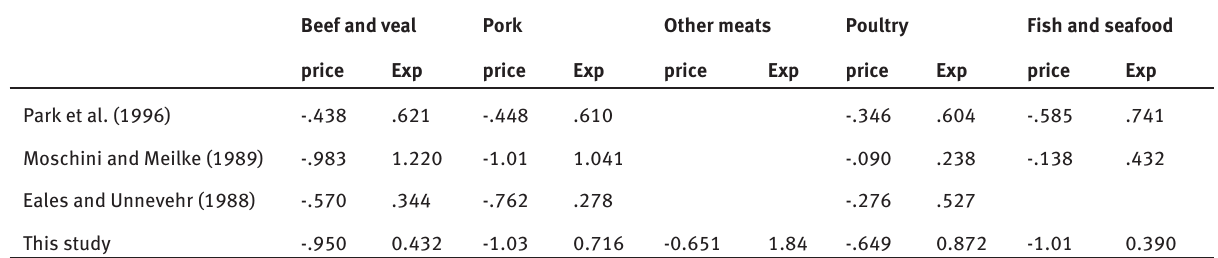
Table 7: Comparison of estimated own price and expenditure elasticities among different studies